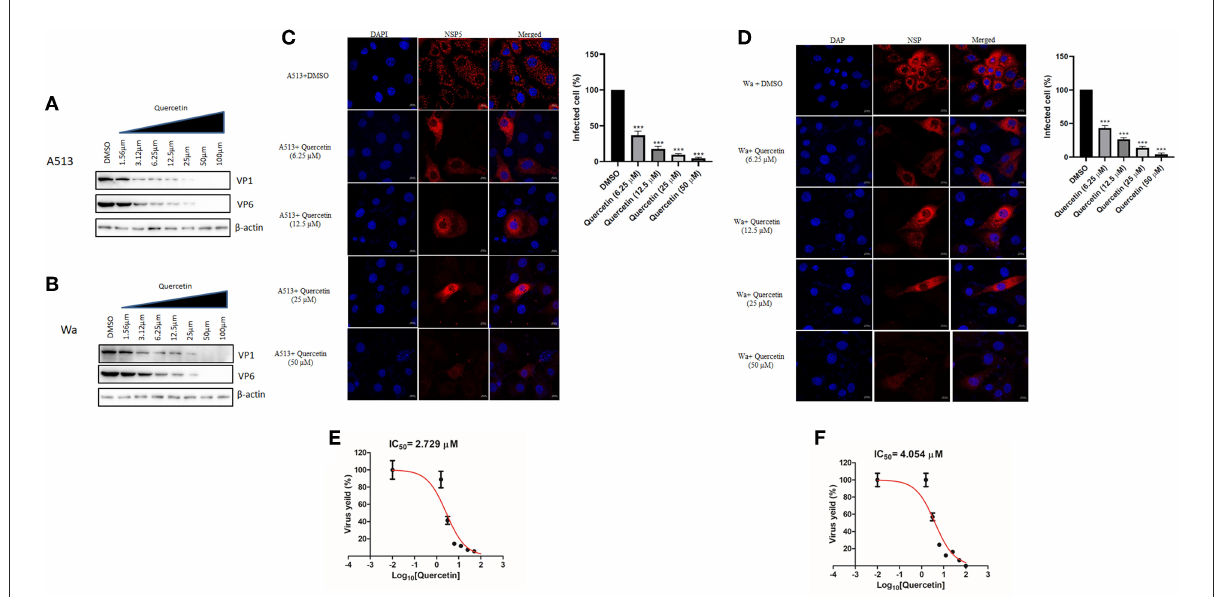
FIGURE2 Quercetin exhibits anti-rotaviral activity independent of viral strain: (A) Cell lysates were prepared to perform Western blot by infecting MA104 cells with RV-A513 strain followed by treatment with DMSO or increasing concentration of quercetin (1.56, 3.125, 6.25, 12.5, 25, 50, and 100 µ M) to assess viral protein expression. The expression of β -actin is checked as internal loading control. (B) Similarly, RV-Wa strain-infected MA104 cells are treated with DMSO or increasing doses of quercetin (1.56, 3.125, 6.25, 12.5, 25, 50, and 100 µ M) to check viral proteins along with β -actin as loading control. (C,D) MA104 cells were infected with (C) RV-A5-13 and (D) RV-Wa (MOI 3) in the presence of DMSO and quercetin (6.25, 12.5, 25, and 50 µ M) for 6 hpi. Cells were fixed, permeabilized, and stained primarily with anti-NSP5 antibody (raised in rabbit). Next, secondary staining was done with rhodamine-labeled anti-rabbit secondary antibody. DAPI was used for mounting. Finally, cells were visualized with confocal microscope (63 × oil immersion); scale bar 10 µ m. Viroplasm positive cells are quantified and analyzed by taking into account minimum 100 cells selected randomly from each experimental slides. The data were represented as mean-infected cells (%) ± SD of three experimental replicates. (E,F) IC 50 was calculated from the quantification of viral particle produced by plaque assay which was performed from (E) A5-13- and (F) Wa-infected MA104 cells treated with DMSO and graded concentration of quercetin (1.56, 3.125, 6.25, 12.5, 25, 50, and 100 µ M), for 24 hpi. Each bar represents mean ± SD of three independent experiments (Unpaired student’s t-test, *** p <